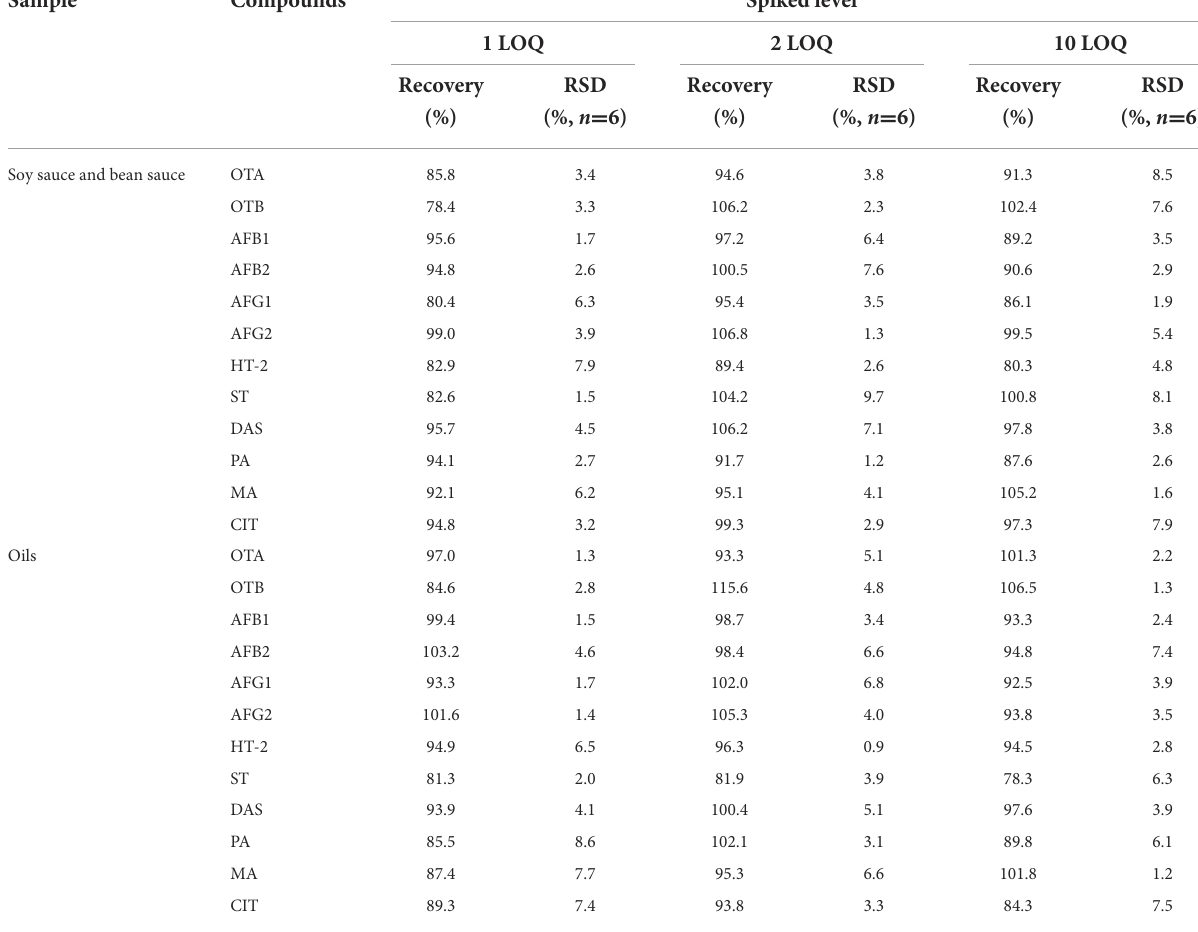
TABLE 4 Recoveries and RSDs ( n = 6) of blank samples fortified with 12 mycotoxins.